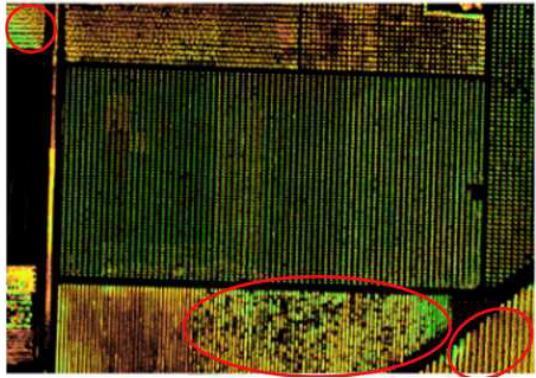
Figure 13. Low-altitude remote sensing image of pest